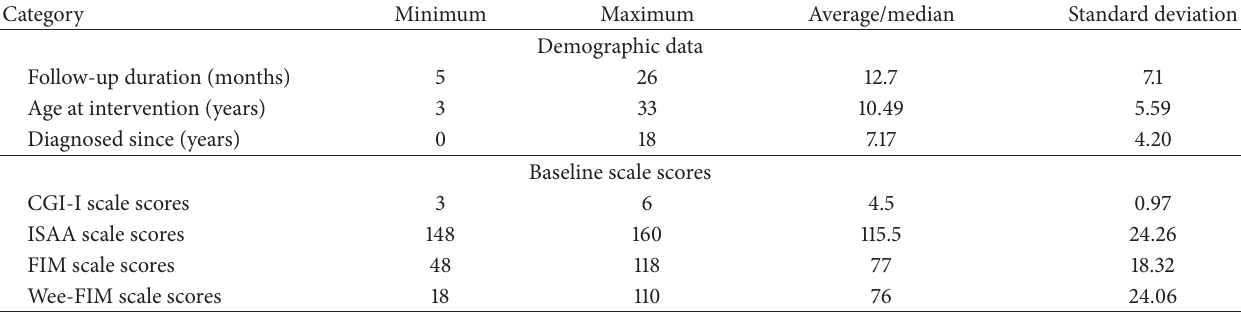
Table 1: Demographic data and scores of CGI, ISAA, FIM, and Wee-FIM scales before cell transplantation.